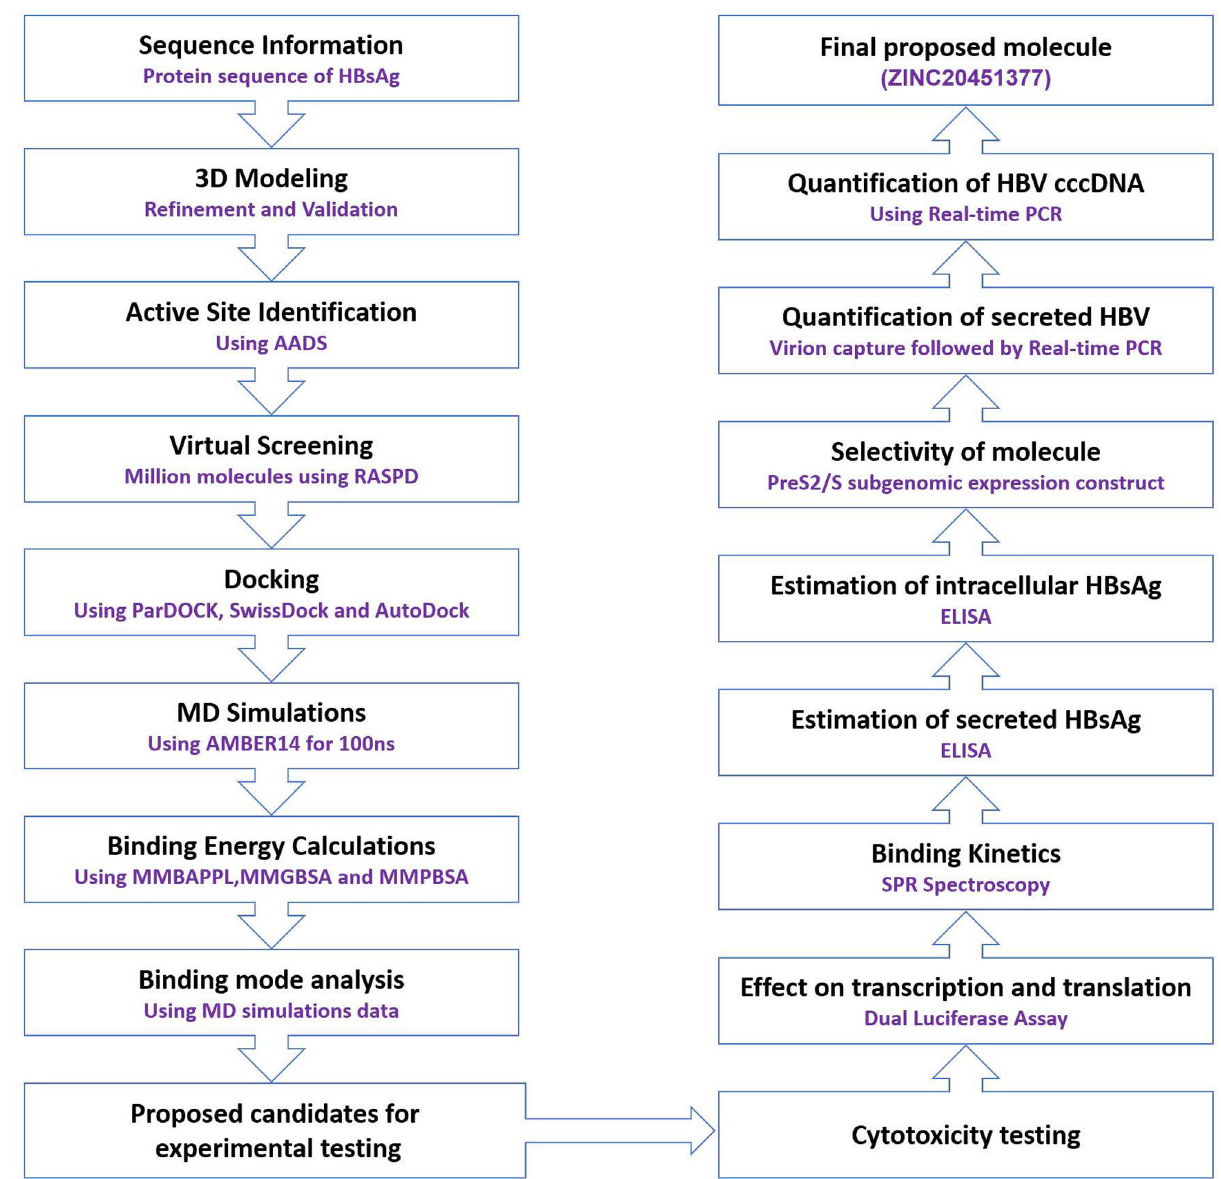
Figure 6. Flowchart of the workflow used for identification of molecule 5 (ZINC20451377) as an inhibitor of HBsAg that results in inhibition of hepatitis B